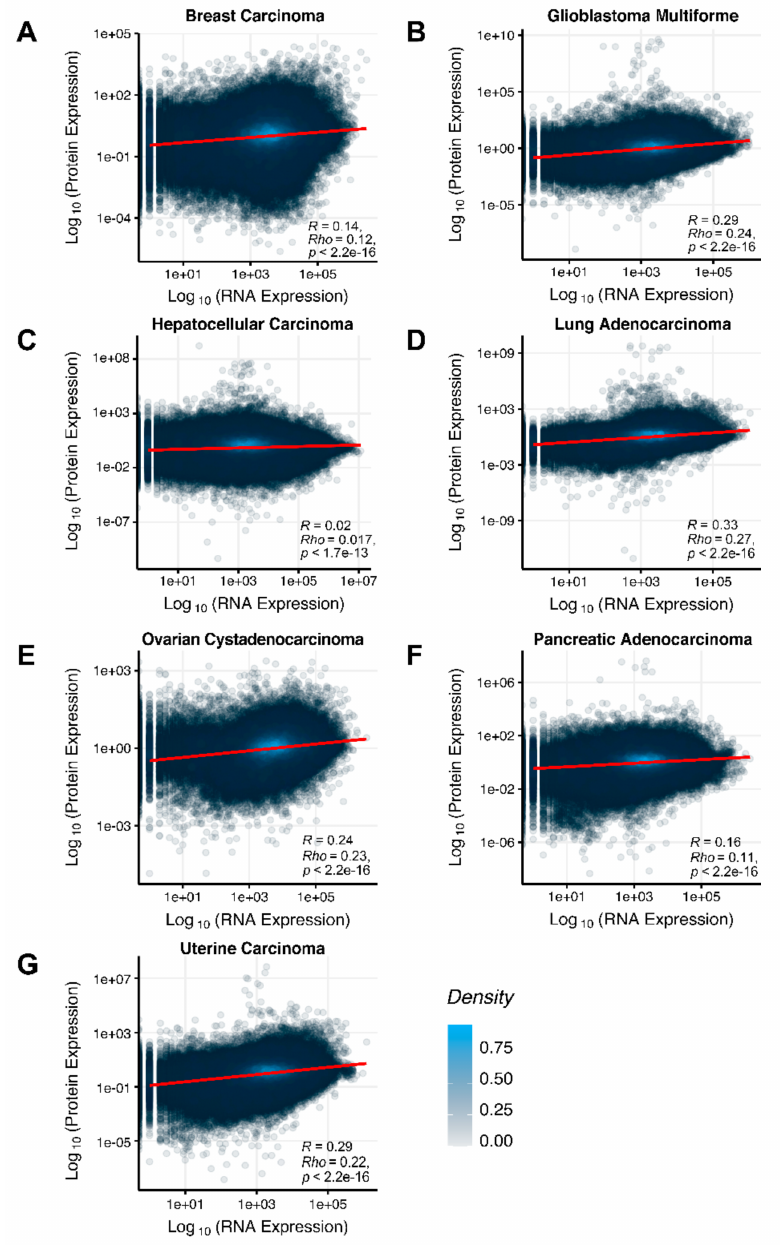
Figure 2. Gene-to-gene Spearman correlation between RNA and protein expression levels for an average biosample estimated across ( A ) Breast Invasive Carcinoma, ( B ) Glioblastoma Multiforme, ( C ) Hepatocellular Carcinoma, ( D ) Lung Adenocarcinoma, ( E ) Ovarian Serous Cystadenocarcinoma, ( F ) Pancreatic Ductal Adenocarcinoma and ( G ) Uterine Corpus Endometrial Carcinoma. Each dot represents a unique gene-sample